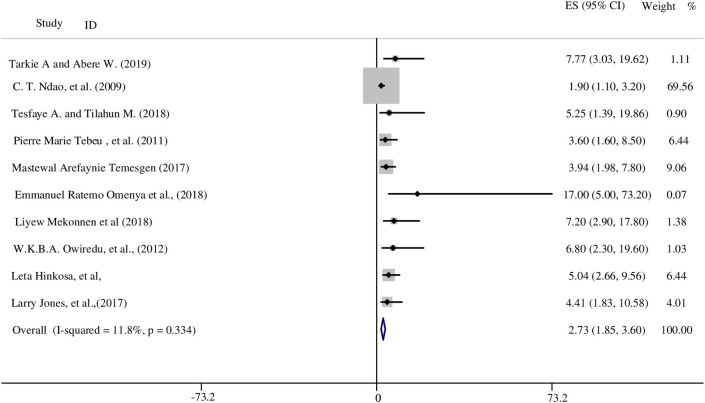
The association between family history of HDP and HDP in SSA.